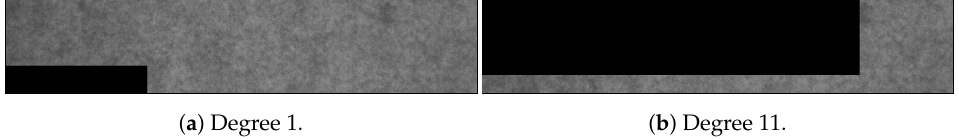
Figure 5. Examples of altered documents with simulations of tear damage; in particular ( a ) represents the first degree of damage while ( b ) the last (e.g.,